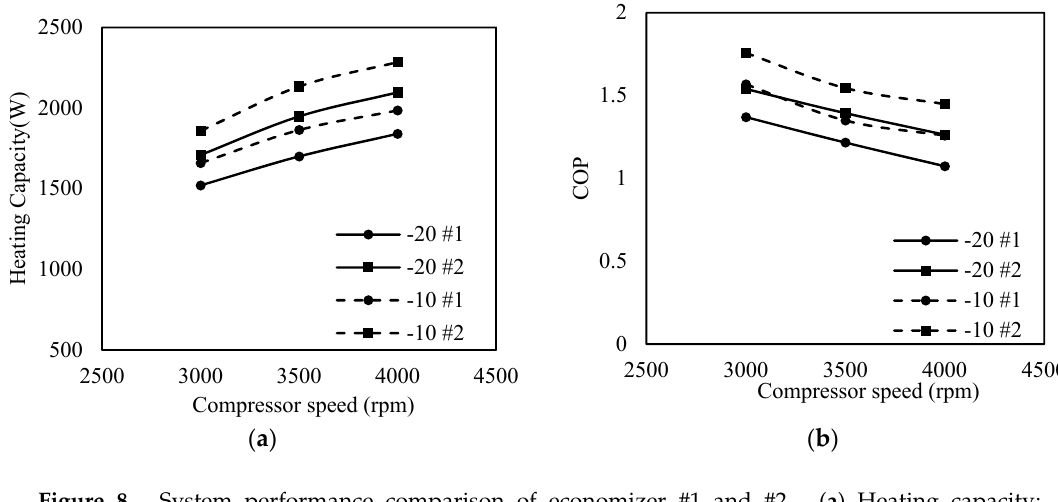
Figure 8. System performance comparison of economizer #1 and #2. ( a ) Heating capacity; ( b ) Heating COP.